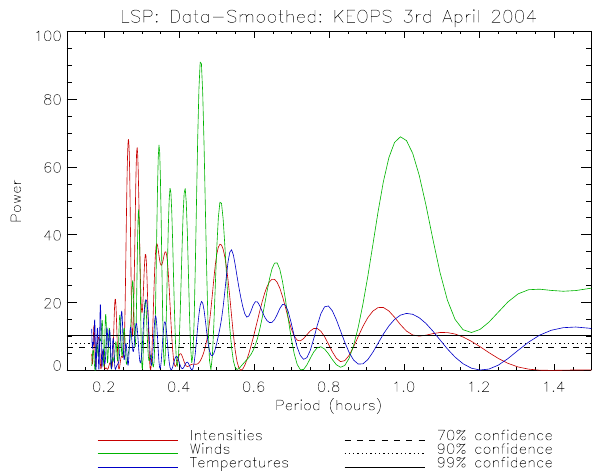
Fig. 8. Lomb-Scargle Periodogram of smoothed intensities, winds, and temperatures, from KEOPS data on 3 April 2004, using a 30- min running smoothing value.